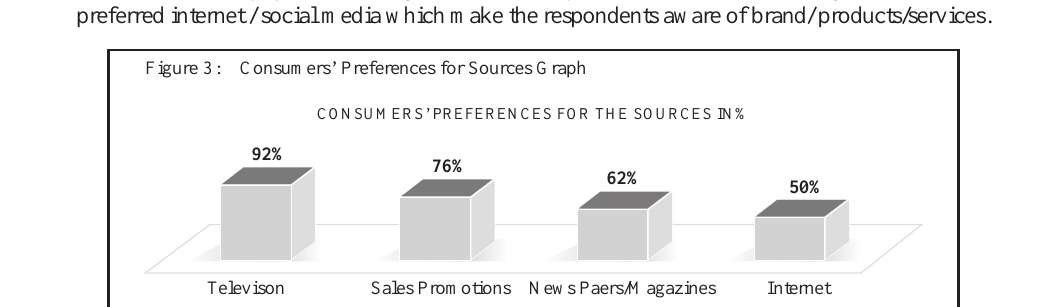
Figure 3: Consumers’ Preferences for Sources Graph